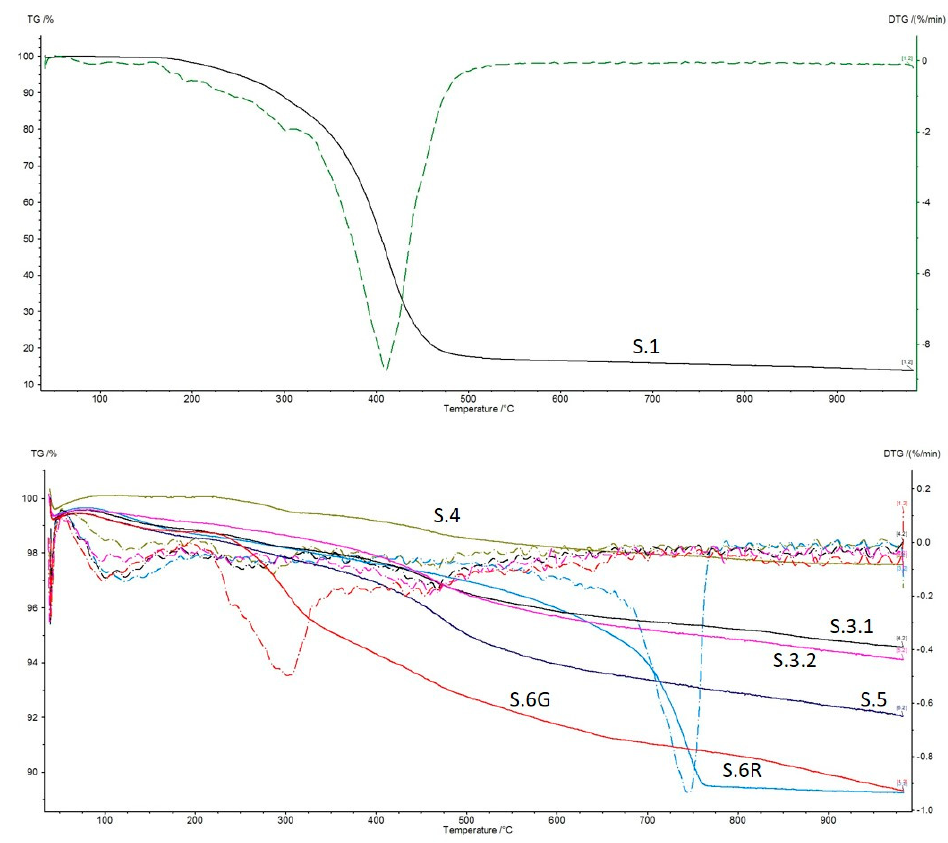
Figure 6. Thermogravimetric curves (—TG and — DTG) of the mortar samples’ global fraction. Dashed lines for DTG with same color code of TG. Labels refers to the sample references.